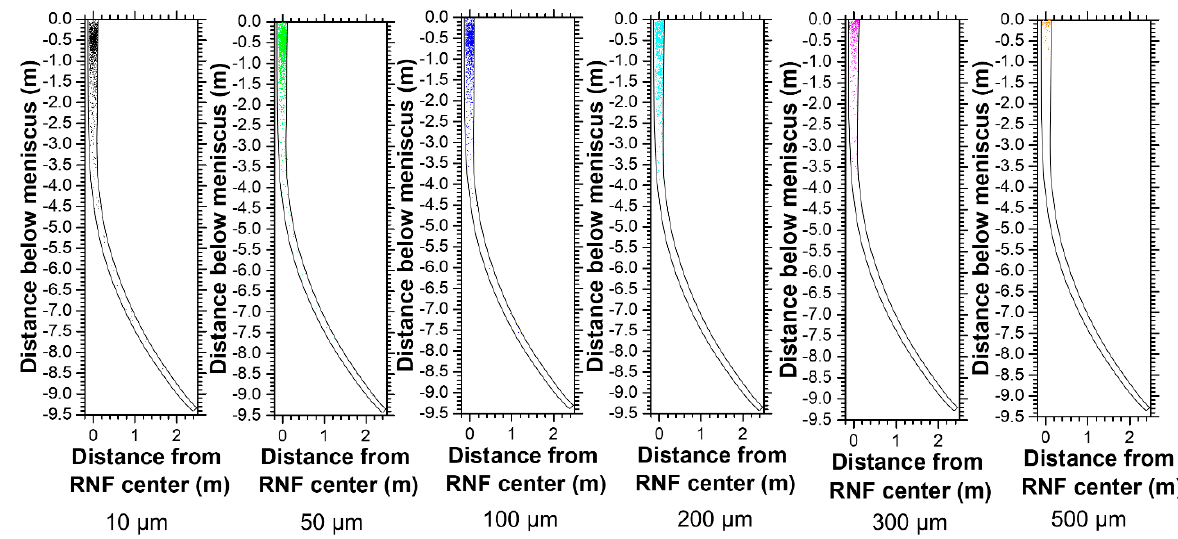
Figure 9. Inclusion capture locations on the right NF shell, by inclusion size (side view).